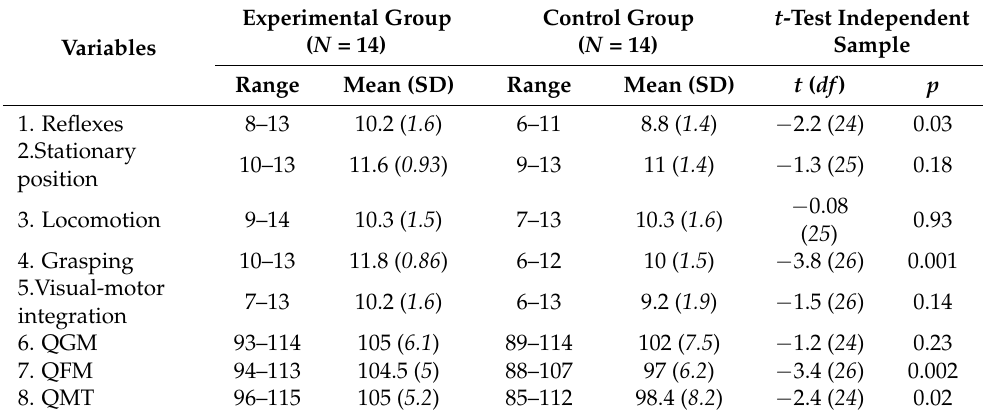
Table 2. Group comparison of Peabody Developmental Motor Scale Second Edition (PDMS-2)